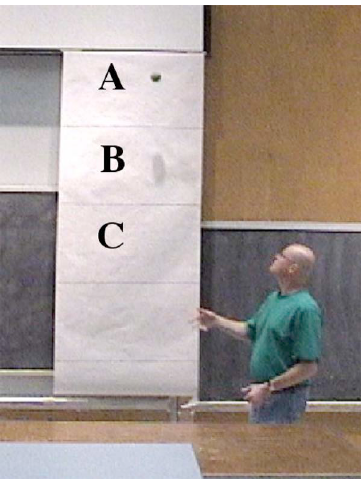
FIG. 2. (cid:1) Color (cid:2) Ball toss problem for discussing the probability of finding a ball in a given region when thrown